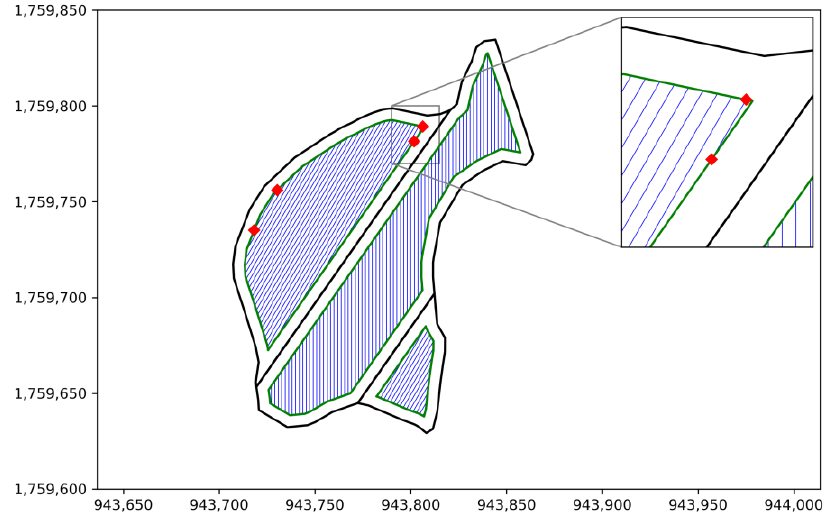
Figure 10. Four entry points for an example subfield. 254 The next step is to include the turning tracks into the continuous path as well. To do 255 so, a point on each headland track must be defined as a starting point for that respective 256 headland track. To define the starting point, a straight line from the entry point is drawn 257 which is perpendicular to the infield track. The intersection of that line and the headland 258 tracks determine the starting point of each headland track. An example of the headland 259 track starting points can be found in Figure 11.